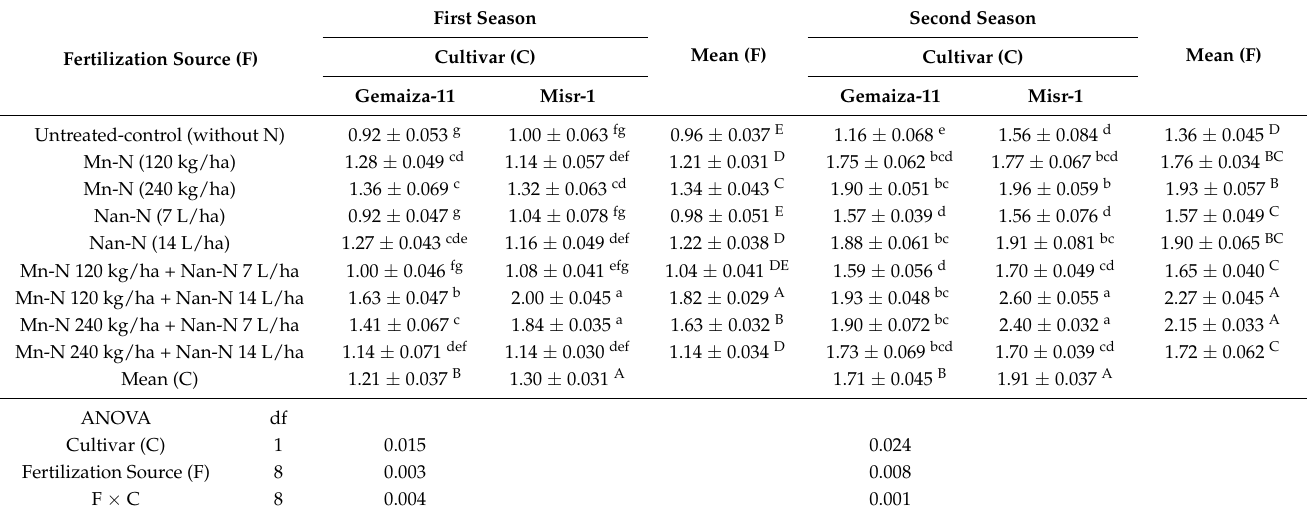
Table 9. Impact of nano- and mineral nitrogen fertilizers on the nitrogen concentrations (Conc; mg/L) of two wheat cultivars during the 2019/2020 and 2020/2021 seasons.